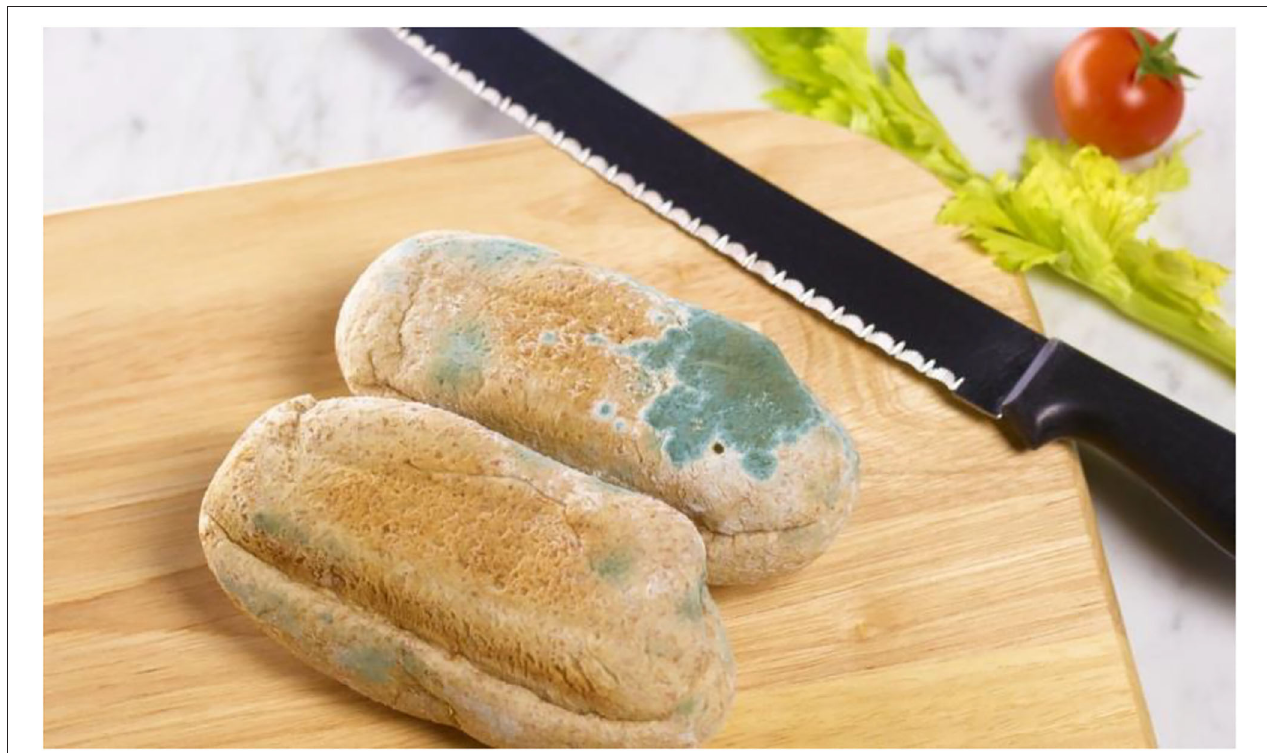
FIGURE 5 | It has been suggested by some that our aversion to blue-green foods comes from the fact that moldy foods often take on this appearance (figure courtesy of Peter Dazeley/Getty